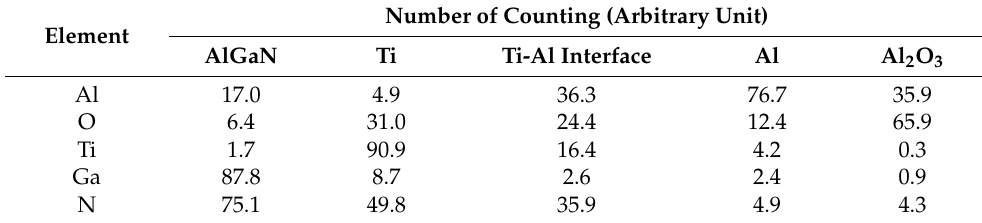
Figure 8. Elemental content in each position in weakly annealed area 1. Table 3. The average content of the elements within each layer in area 1.